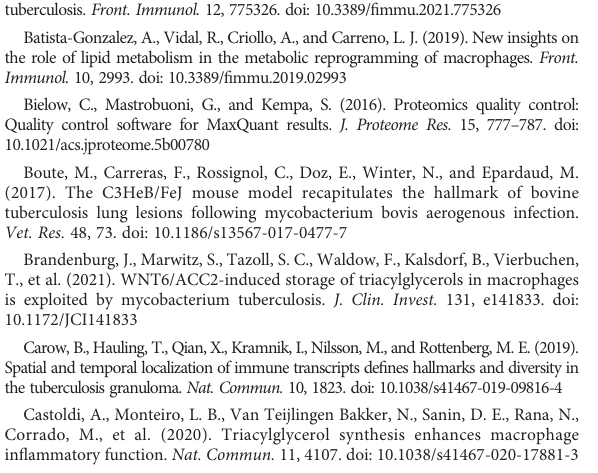
SUPPLEMENTARY TABLE 5 Antibodies used in this